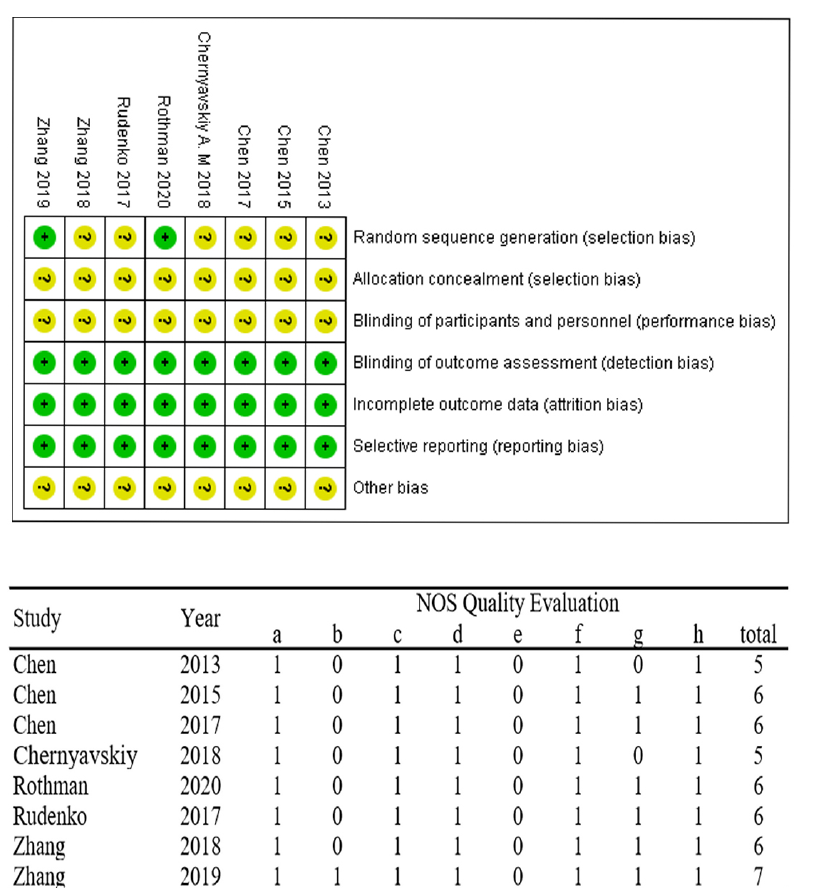
Fig. 2 - Risk of bias graph: the green color indicates low risk of bias, and the yellow indicates unclear risk of bias. Newcastle-Ottawa Scale (NOS): a=representativeness of exposed cohort; b=representativeness of non-exposed cohort; c=ascertainment of exposure; d=demonstration that outcome of interest was not present at the start of study; e=comparability; f=assessment of outcome; g=duration of follow-up; h=adequacy of